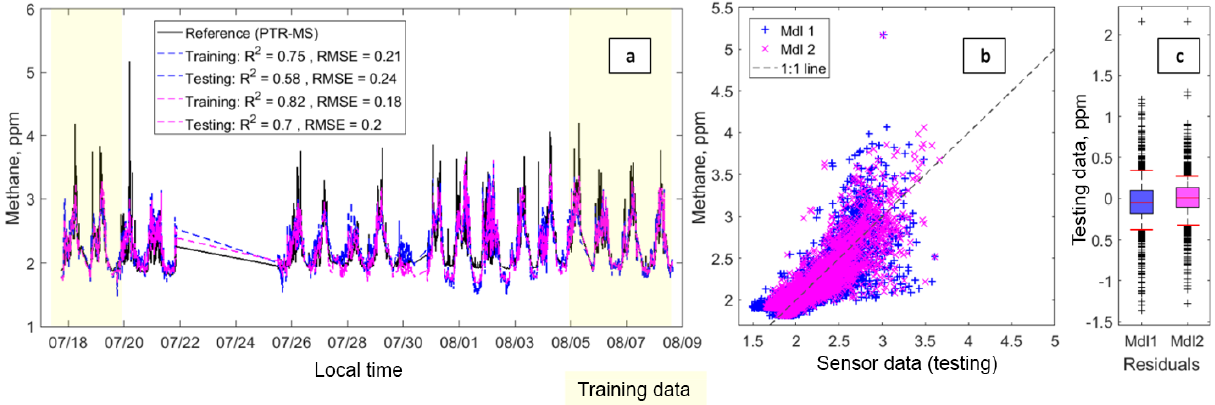
Figure 5. Panel (a) depicts a time series including the methane data from the Los Gatos cavity ring-down instrument and the fitted sensor data from Model 1 (in blue) and Model 2 (in fuchsia). The text box includes the following statistics: coefficient of determination ( R 2 ) and the root-mean-squared error (RMSE) in that order for each testing and training dataset. Panel (b) depicts a scatter plot of the testing data for Model 1 (in blue) and Model 2 (in fuchsia); the 1:1 line has also been added. Panel (c) depicts box plots of the residuals with the whiskers at the fifth and 95th percentiles (in